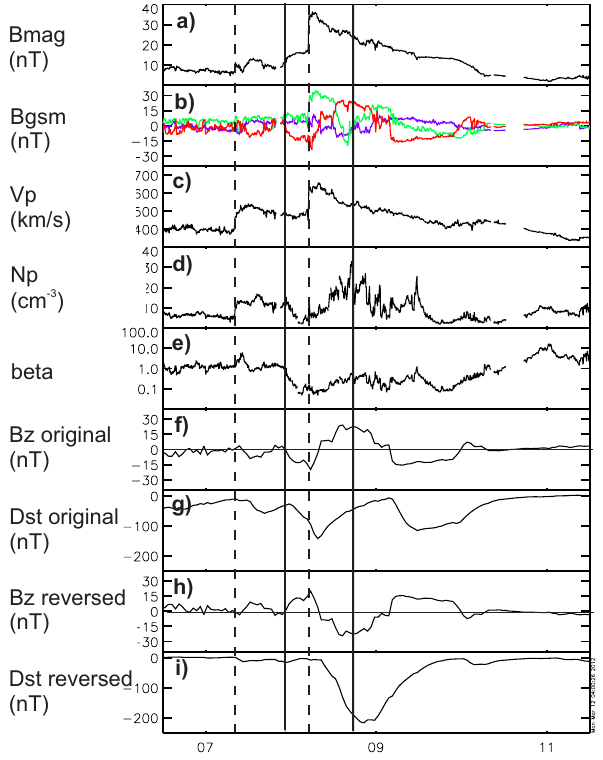
Fig. 4. Solar wind plasma and magnetic field measurements up- stream of the Earth on 7–9 November 1998 featuring two interacting magnetic clouds. The storm driven by the reversed-SN cloud was the strongest in our dataset. The panels are same as in Fig. 2. The first dashed line shows the shock associated with the first cloud and the second dashed line indicates the shock driven by the following cloud.